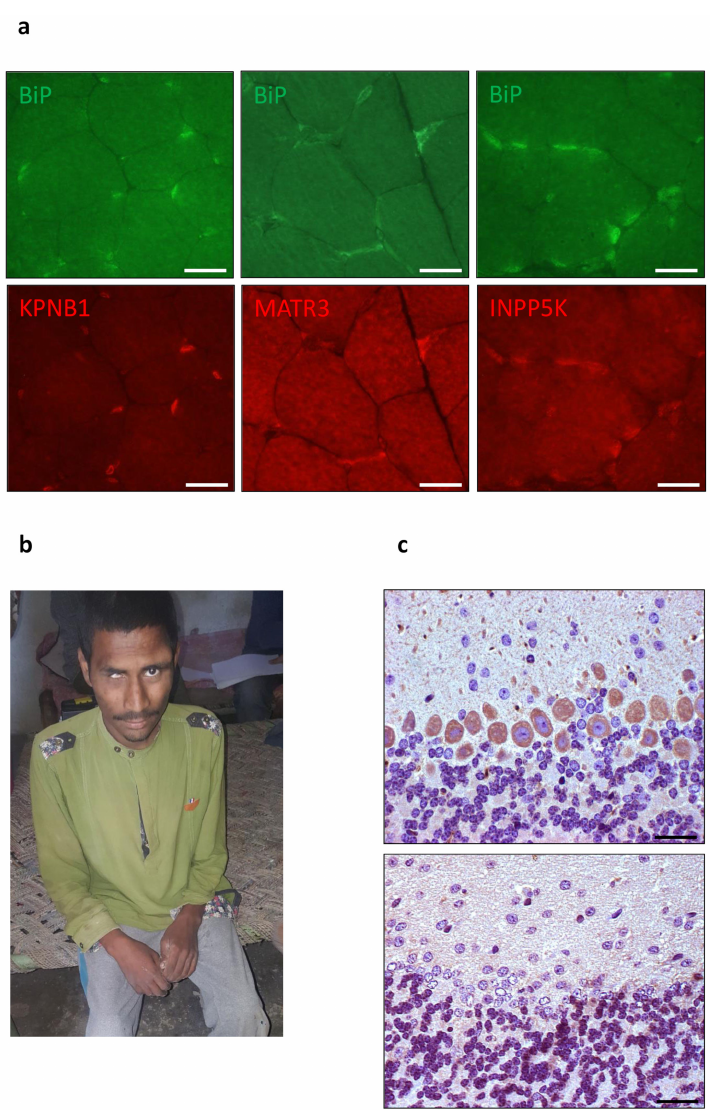
Figure 8. Marinesco–Sjögren-Syndrome. ( a ) BiP-enrichment in the nuclear envelope of muscle cells visualized by co-immunofluorescence on a human quadriceps muscle biopsy from a healthy donor; left panel highlights co-localization of BiP with KPNB1 (Importin subunit beta-1) within the nuclear envelope, the middle panel illustrates co-localization of BiP with Matrin-3, the right panel illustrates a co-localization of BiP with INPP5K. ( b ) A photograph of a genetically confirmed MSS patient from Pakistan. ( c ) Upper figure shows the cerebellum of a 26-weeks old wildtype mouse with regular appearance and distribution of Purkinje cells immunoreactive for STIM1 (brown labelling: Visualized by immunohistochemistry). Lower figure shows the cerebellum of a 26-weeks old woozy animal (no expression of Sil1 as a BiP co-chaperone) with loss of Purkinje cells. Scale bars: 50 µ